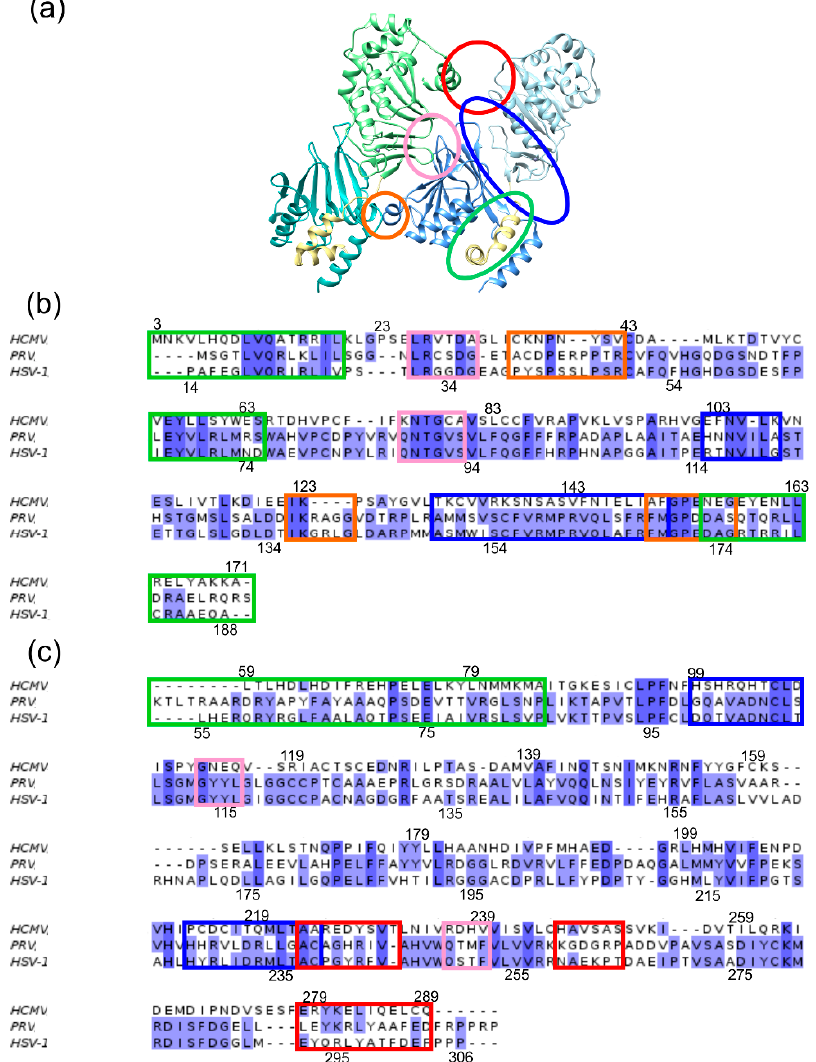
Figure 3 . ( a ) Representation of a section from the Hexagon showing two adjacent HCMV NEC heterodimers. The proteins are coloured according to the scheme established in Figure 1. The interfaces are marked by coloured ellipses: PIF (green), SIF (blue), OIF I (red), OIF II (pink), OIF III (orange). ( b ) Structure-based sequence alignment of pUL50 (pUL34). The sequence regions of the interfaces are framed according to the established colour scheme. The letters are highlighted according to the percentage of sequence identity. ( c ) Structure-based sequence alignment of pUL53 (pUL31). Colour coding as in panel ( b ). Sequence positions for the HCMV and HSV-1 NEC are provided above and below the sequence alignments.